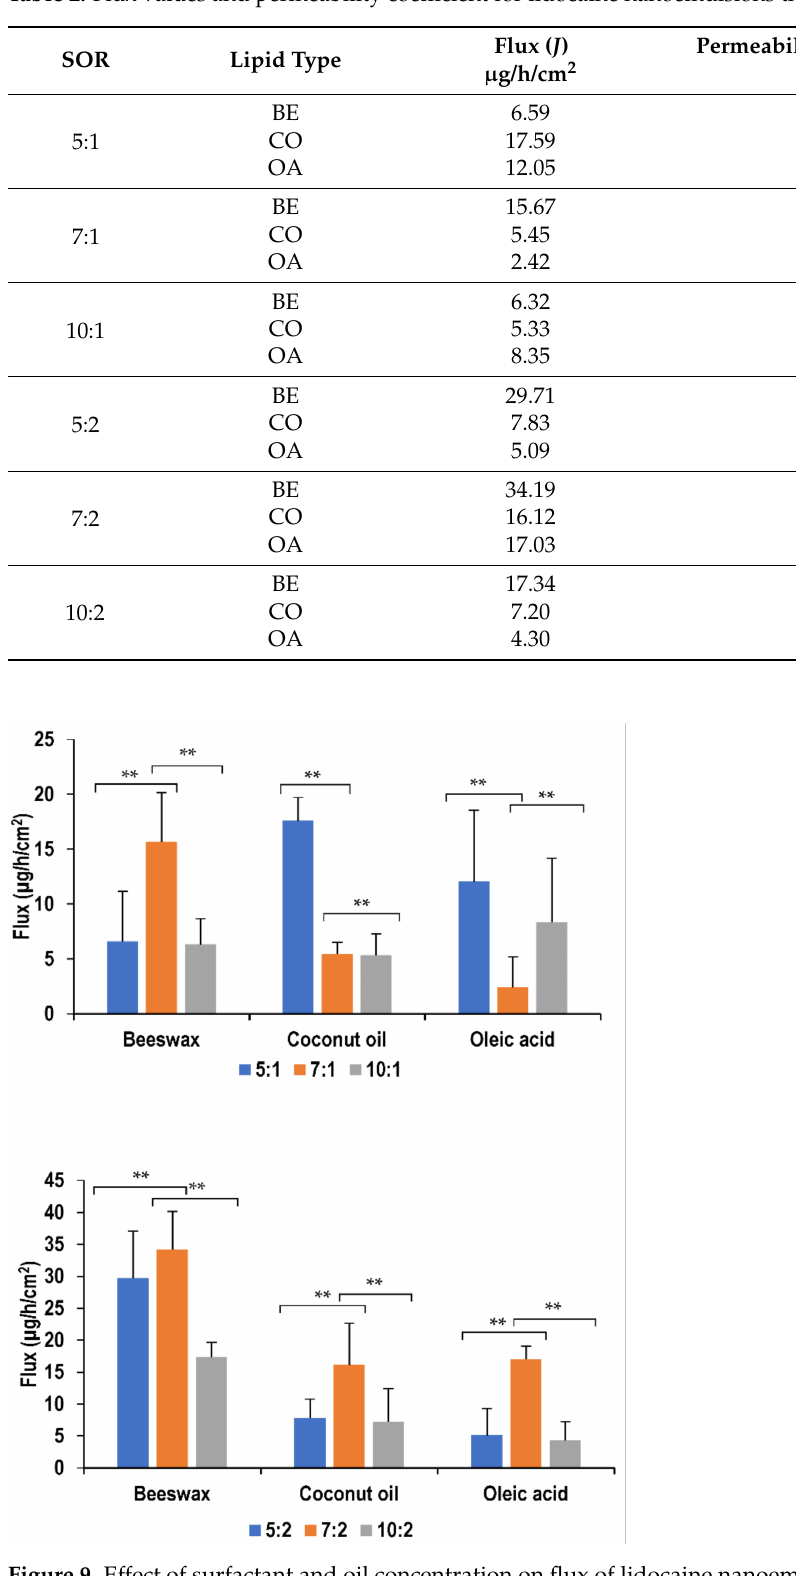
Table 2. Flux values and permeability coefficient for lidocaine nanoemulsions through pig ear skin.